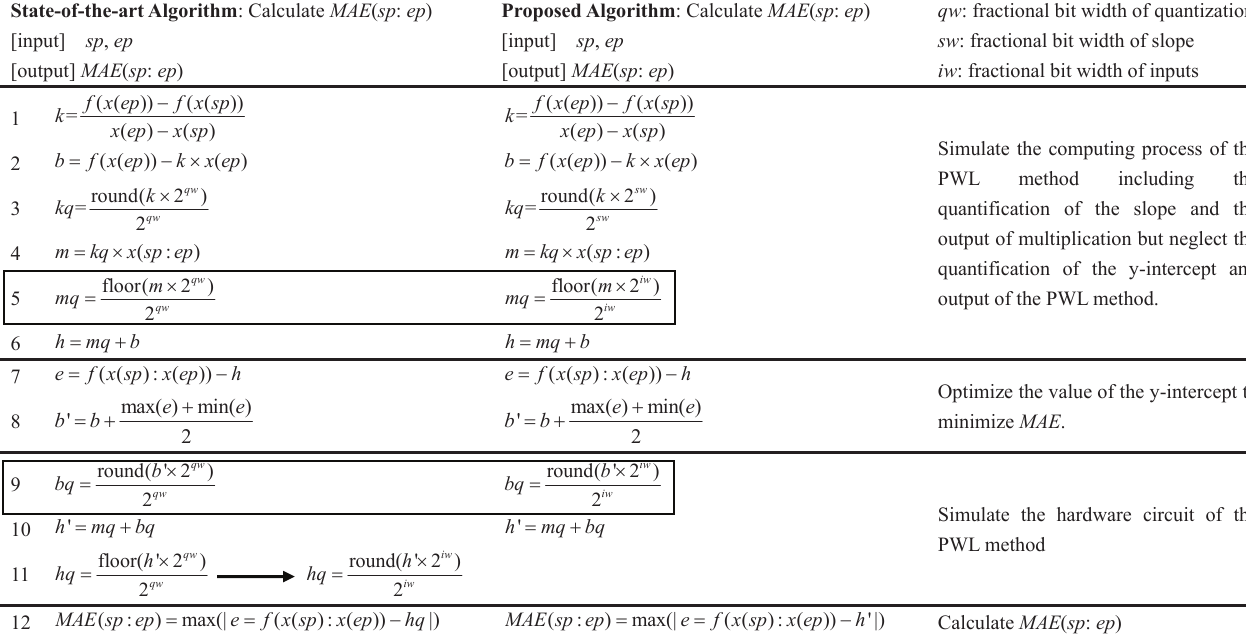
Figure 4. Algorithm for the state-of-the-art segmentor in [30] and the proposed